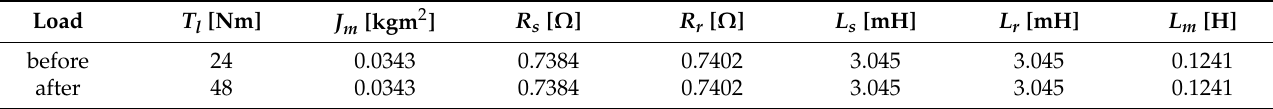
Table 5. IM motor parameters for steady-state before and after load change.